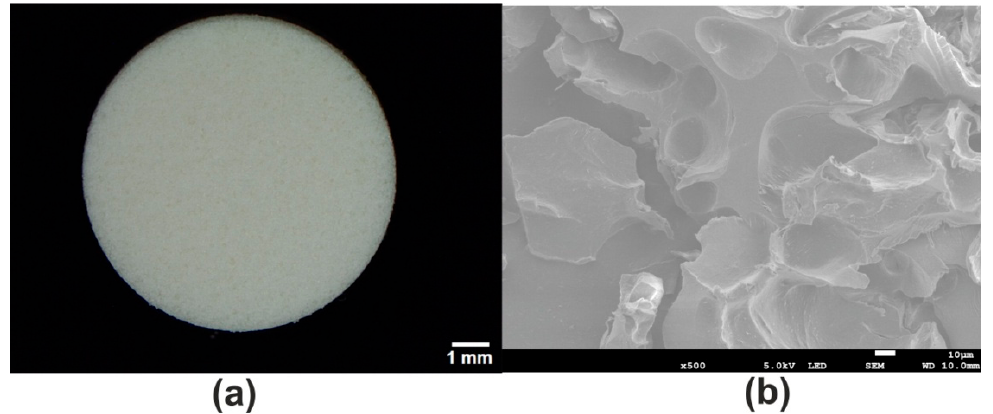
Figure 2. Stereoscopic microscopy ( a ) and SEM ( b ) images showing macro- and microstructures of the novel Cur_WPI scaffold. The magnification and scale bar of the SEM image were 500× and 10 µ m, respectively.